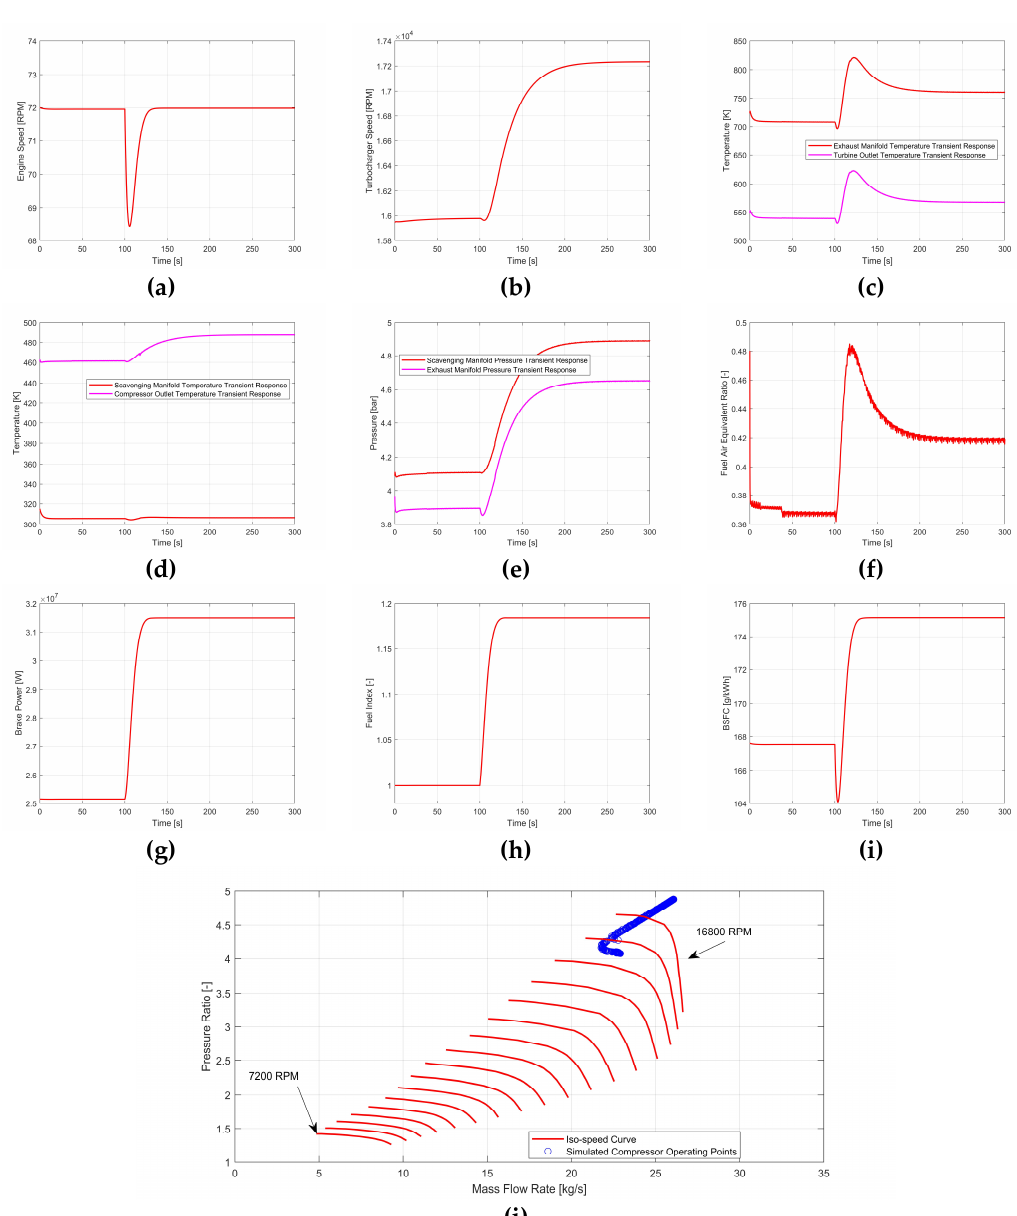
Figure 13. Simulation results for the engine transient operation with resistant torque changes: ( a ) engine rotational speed; ( b ) turbocharger rotational speed; ( c ) exhaust manifold and turbine outlet temperature; ( d ) scavenging manifold and compressor outlet temperature; ( e ) scavenging and exhaust manifold pressure; ( f ) fuel-air equivalence ratio; ( g ) brake power; ( h ) fuel index; ( i ) BSFC; ( j ) compressor operating points trajectory.